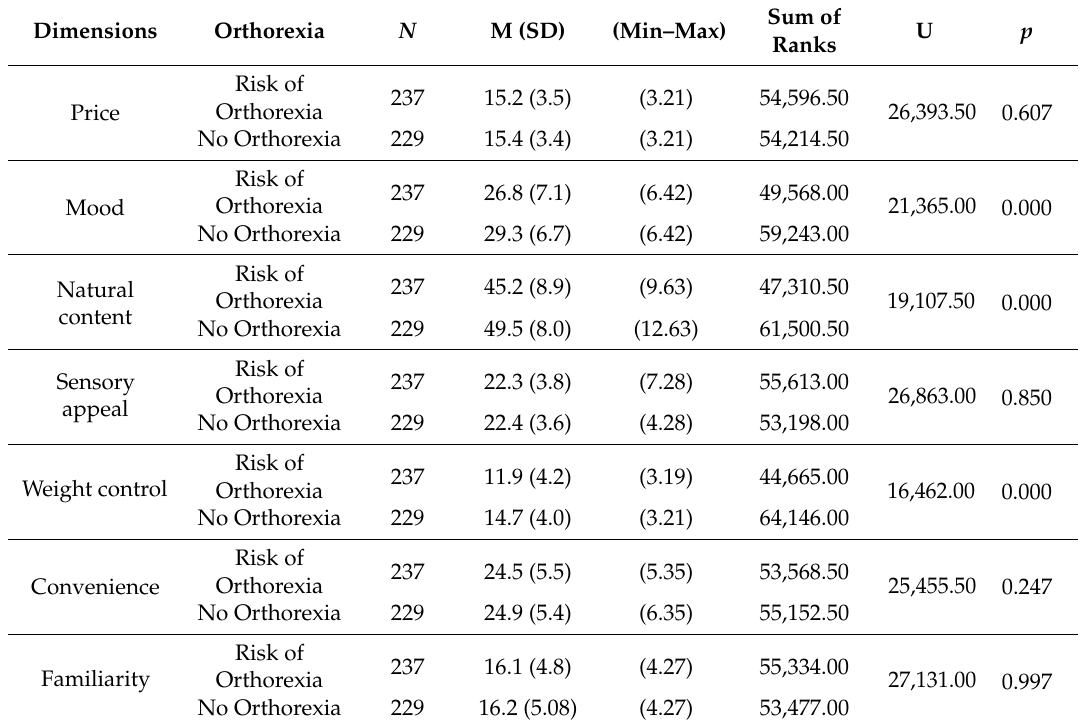
Table 3. The distribution of FCQ-SP scores according to the results of Mann–Whitney U test for the risk of orthorexia and lack of ON (no ON).